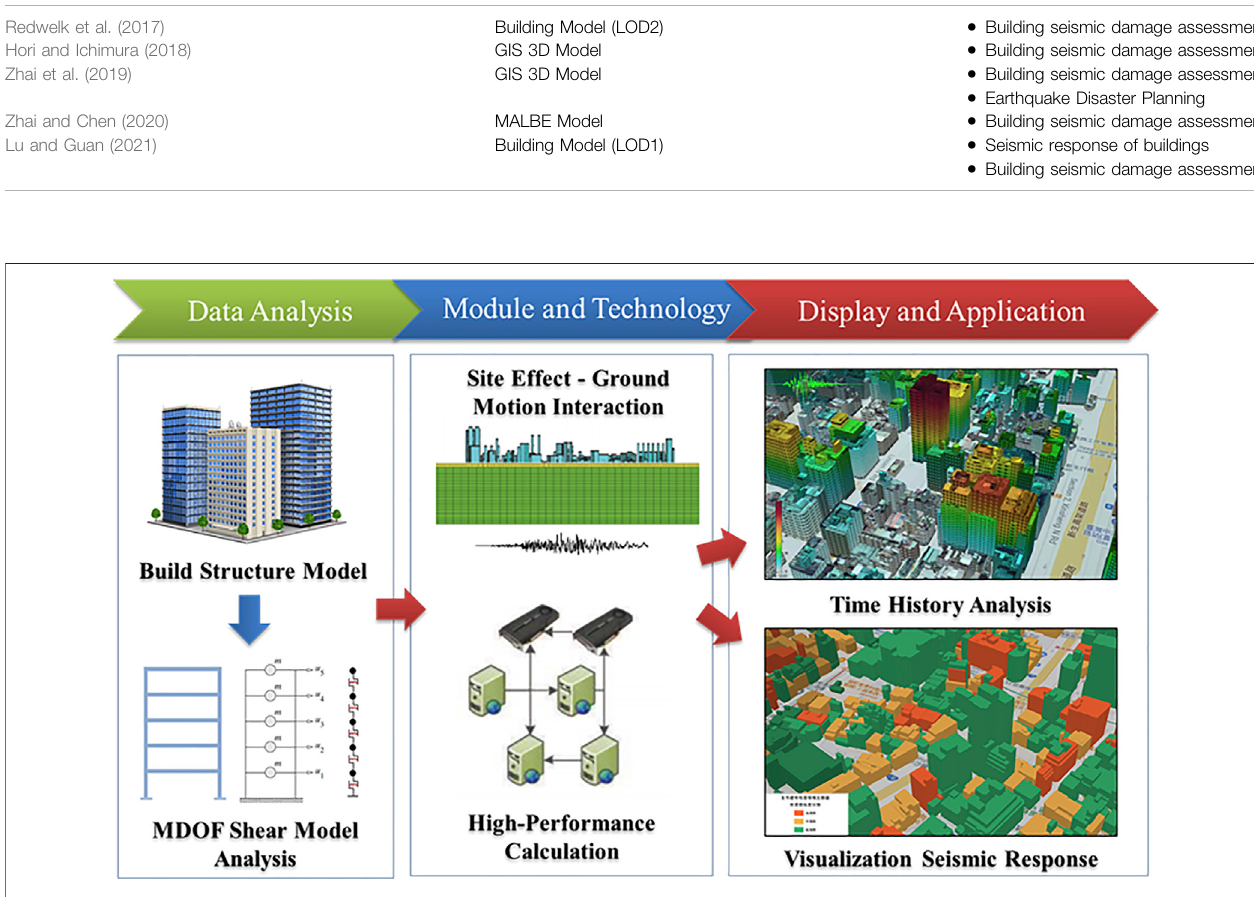
TABLE 1 | Applications of 3D-visualization-assisted assessment of urban earthquake disasters. Literature